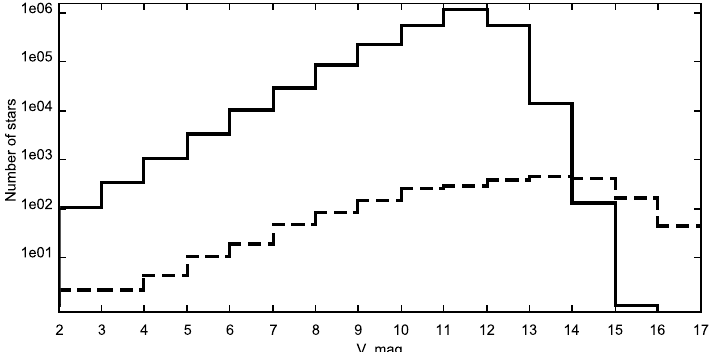
Fig. 4. Distribution of Tycho-2 catalogue stars (solid line) and Algols from the CEV catalogue (dashed line) over